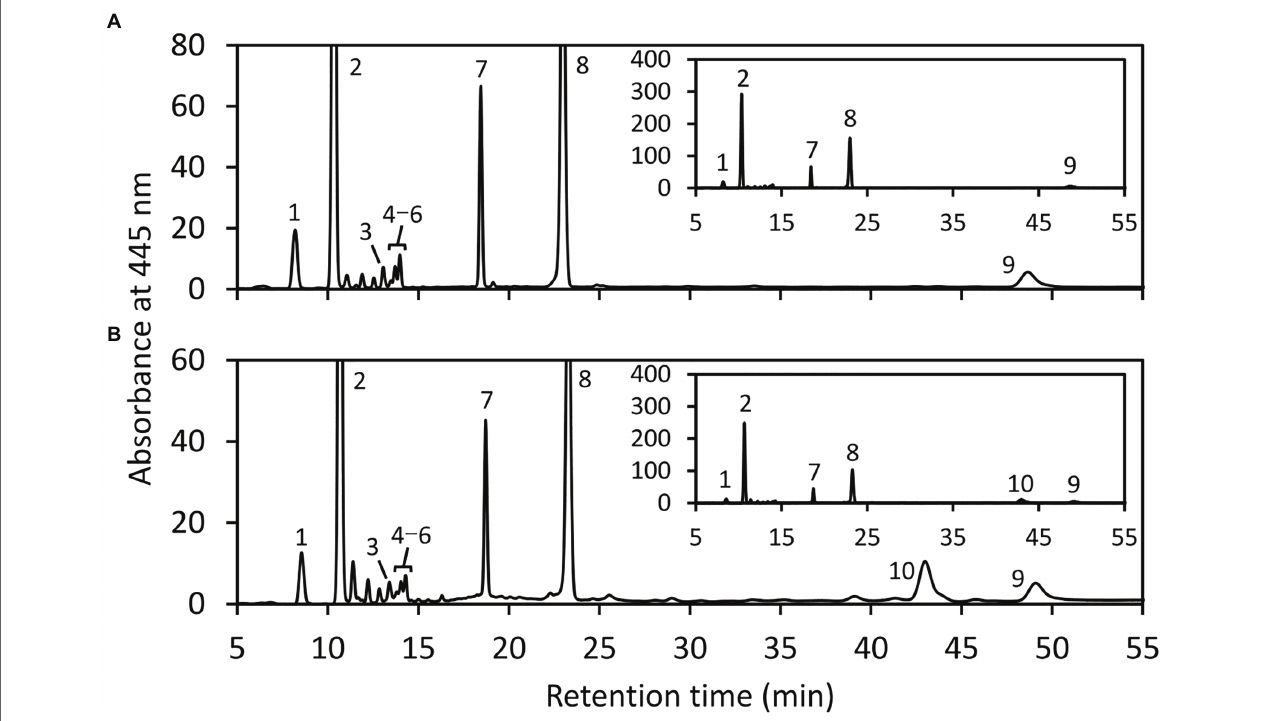
FIGURE 5 | HPLC analysis of carotenoids extracted from E. gracilis . HPLC chromatogram (445 nm) of carotenoid extracts of cells treated without (A) or with EgLCY dsRNA (B) grown under continuous light (40 μ mol m − 2 s − 1 ) at 25 ° C for 6 d. Insets show the same chromatograms with an expanded y axis. Higher number of cells treated with EgLCY dsRNA was used for carotenoid extraction to clearly detect each peak. The absorbance spectra of individual carotenoids and chlorophyll peaks were identical to our previous results (Tamaki et al., 2019) and those of β -carotene and lycopene in Figure 1 . 1, neoxanthin; 2, diadinoxanthin; 3, all trans - diatoxanthin; 4–6, cis -diatoxanthins; 7, chlorophyll b ; 8, chlorophyll a ; 9, β -carotene; and 10, lycopene.